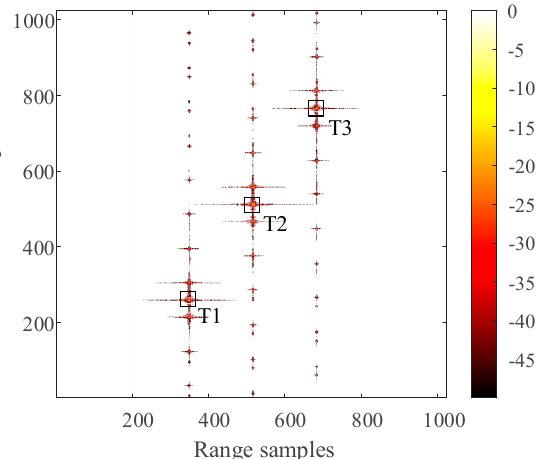
Figure 10. The imaging result of three-point targets with RD algorithm for periodic missing data in azimuth (dB).